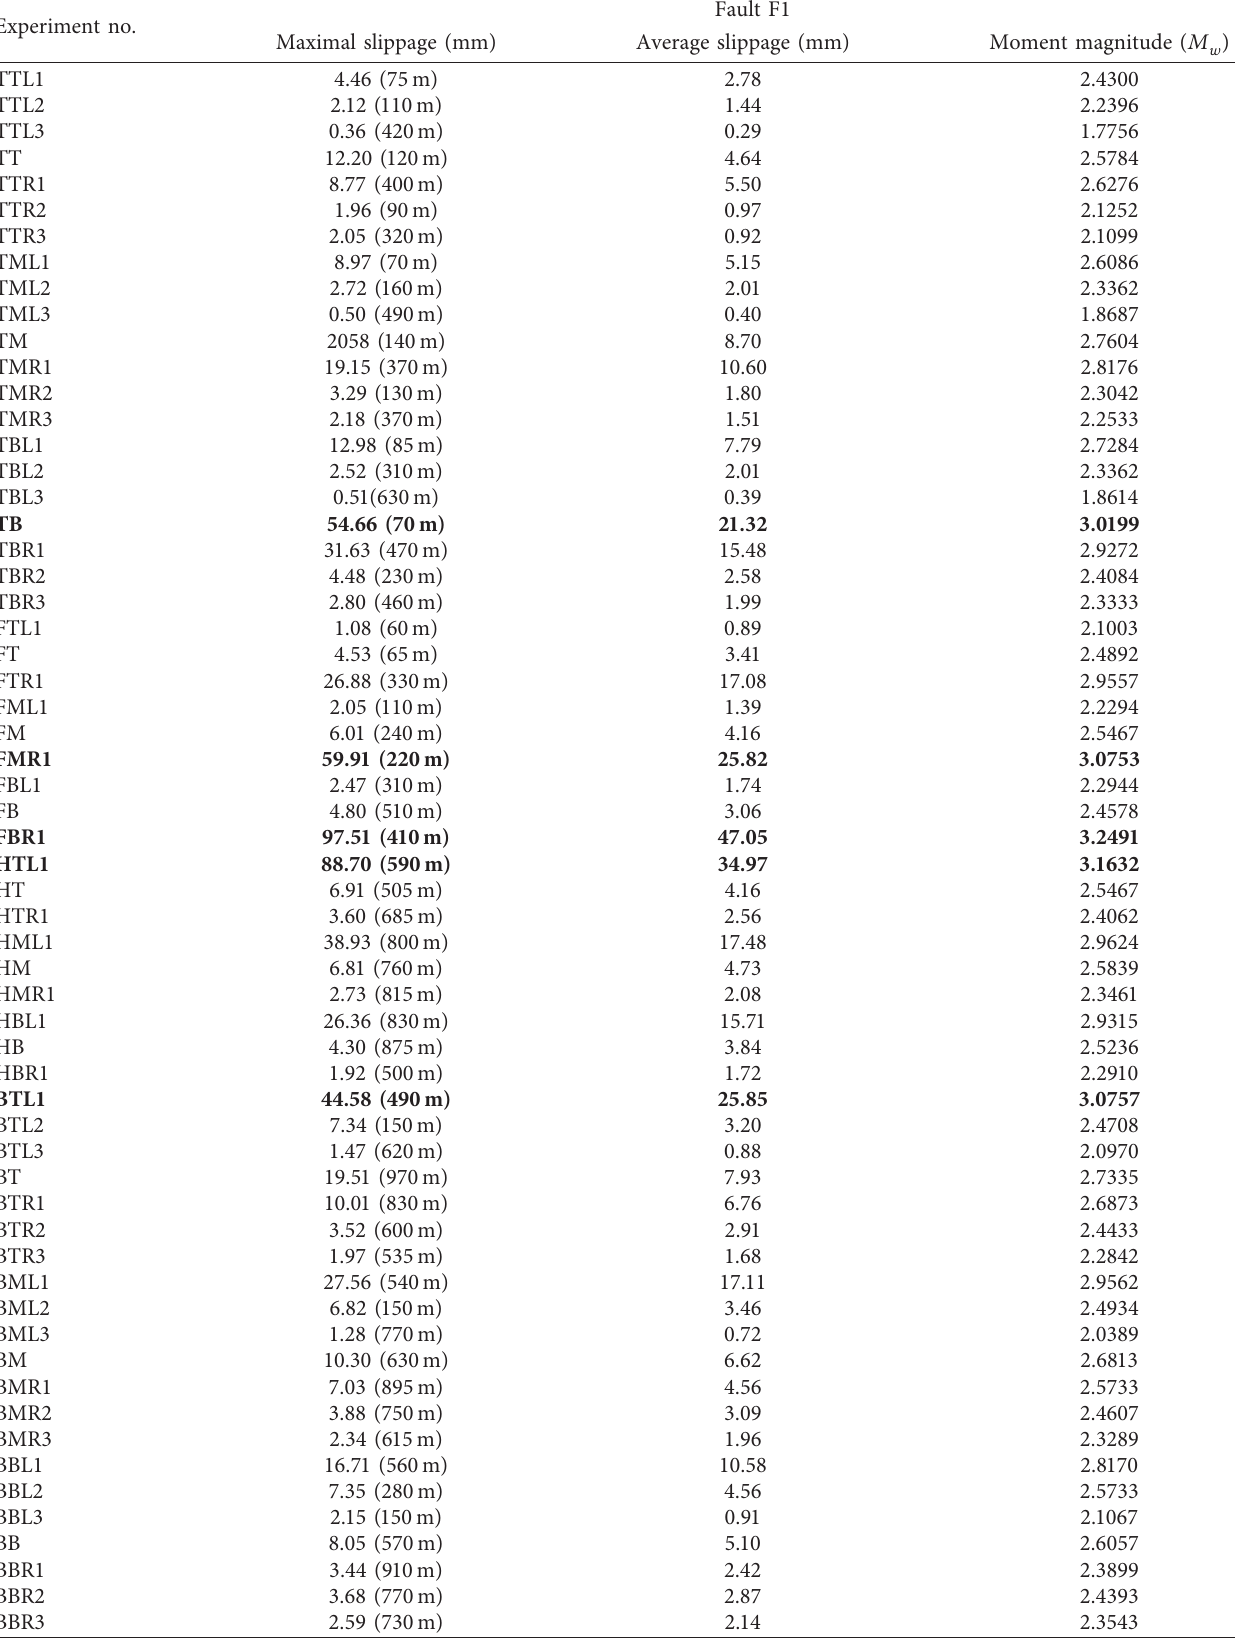
Table 4: The induced maximal slippage, average slippage, and moment magnitude of fault when the pressure was 80 MPa. Experiment